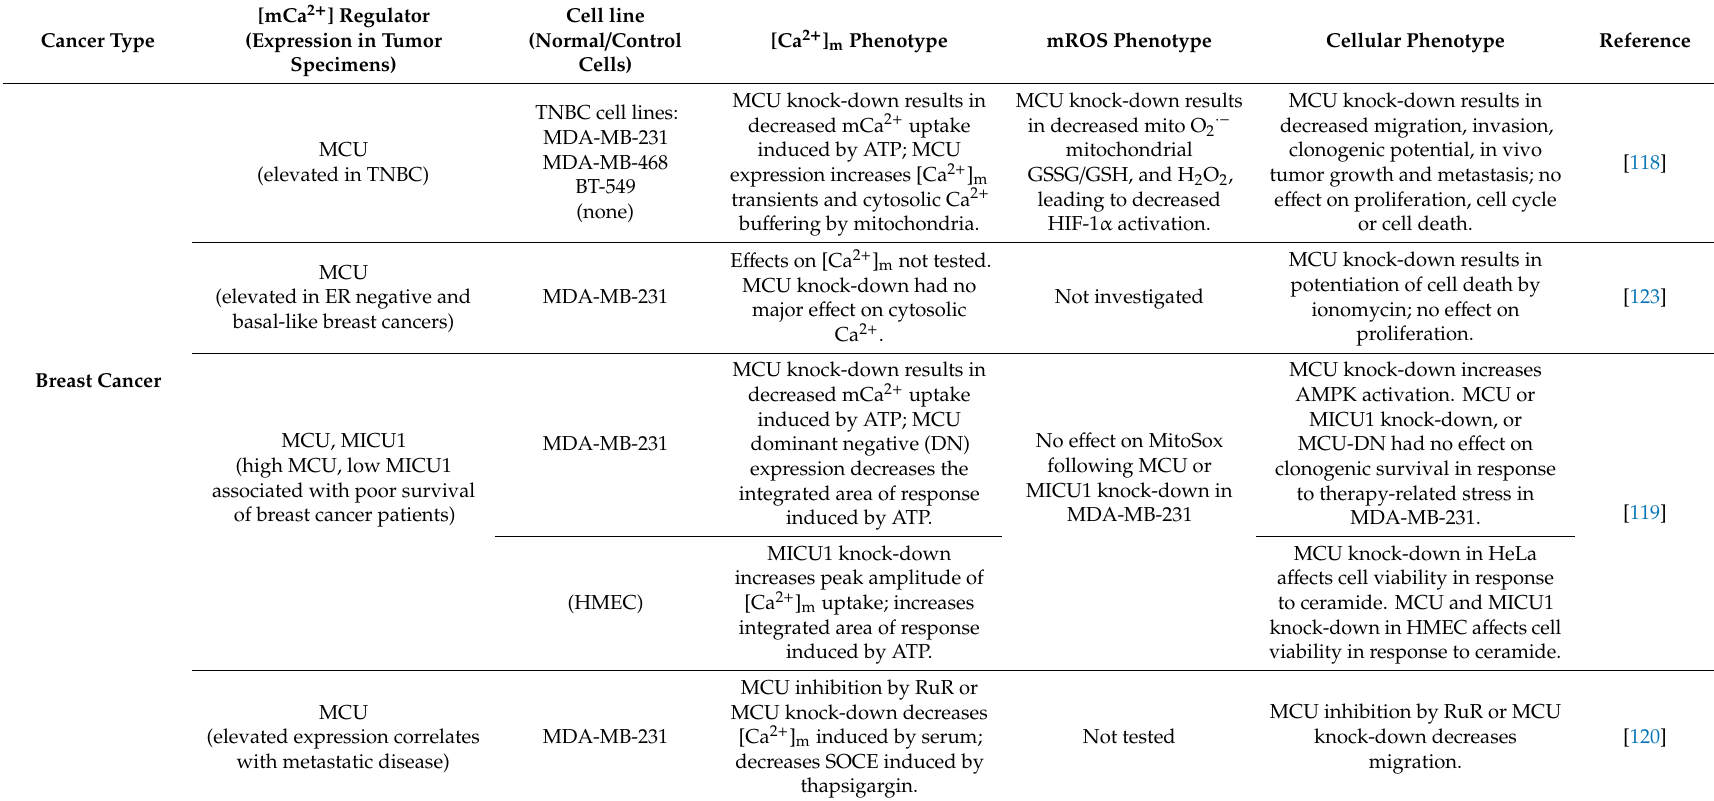
Table 1. Example studies demonstrating the role of [Ca 2 + ]m regulators located in the inner mitochondrial membrane (IMM) on mROS production and redox signaling in